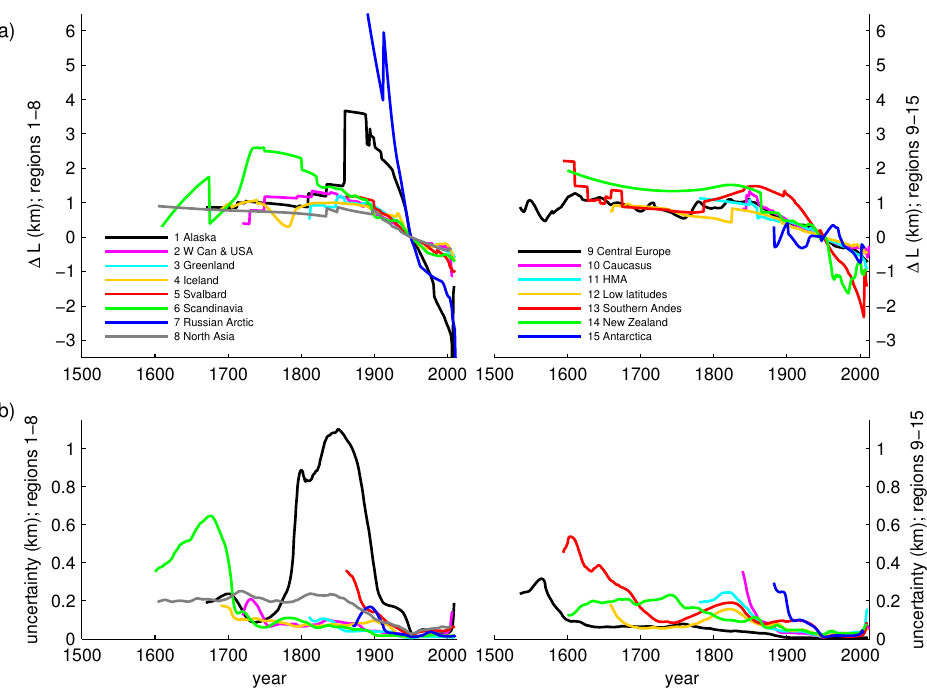
Fig. 9. (a) Regional changes in glacier length over time. For each region, the length change relative to L 1950 is averaged over the available records. The averages have jumps when a new record starts. In the 20th century most regional averages are smooth because the number of available records is larger (cf. Fig. 7). (b) Uncertainty in the regional average due to the uncertainty in the data points and interpolation. Colors of the lines in (b) correspond to those in (a)